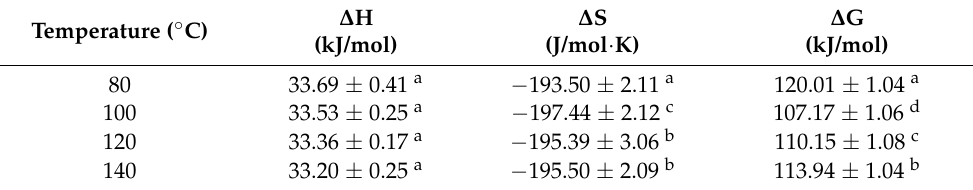
Table 3. Thermodynamic parameters obtained for TAC degradation in red grape skin extract.